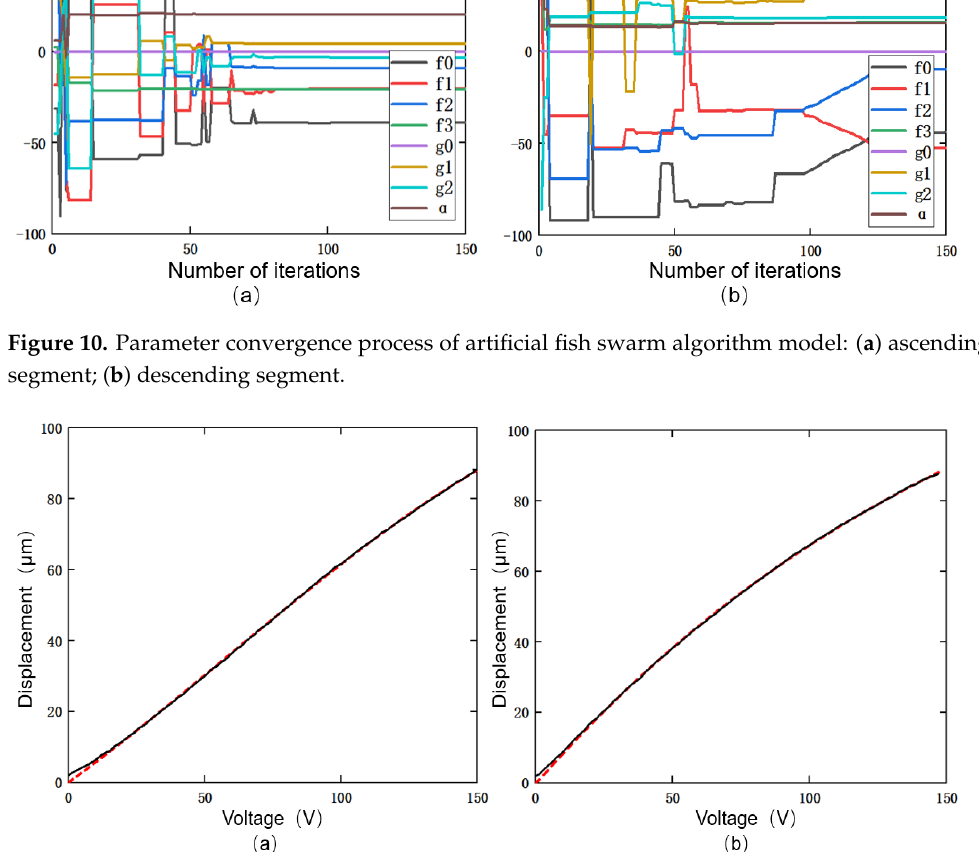
Figure 11. Fitting curve between artificial fish swarm algorithm model data and experimental data: ( a ) ascending segment; ( b ) descending segment.